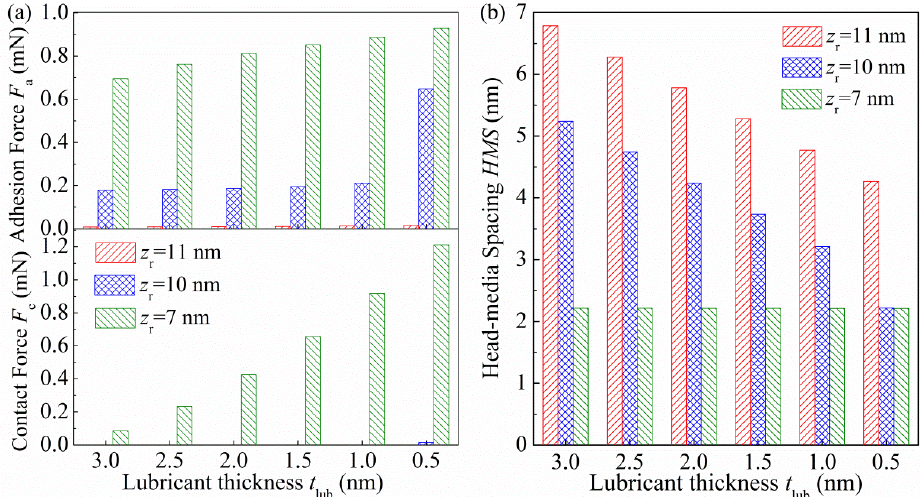
Figure 11. Force and head–media spacing versus the lubricant thickness under t DLC-disk = t DLC-slider = 2